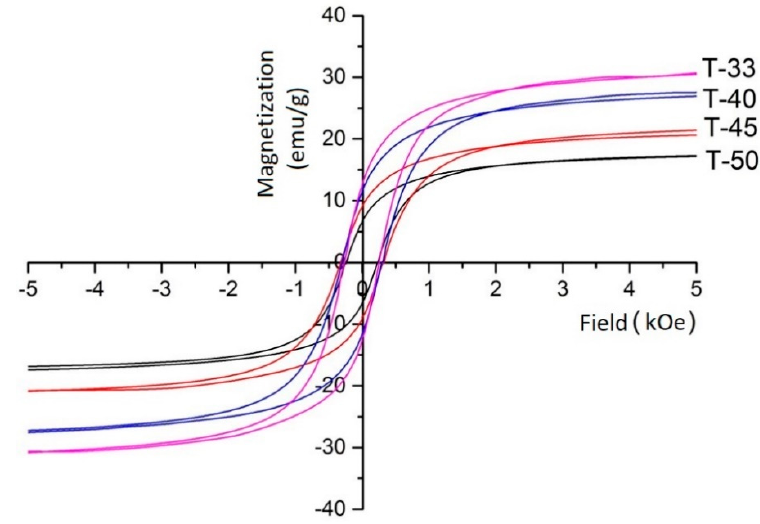
Figure 2. Magnetization curves of composite catalysts measured at 20 °C.